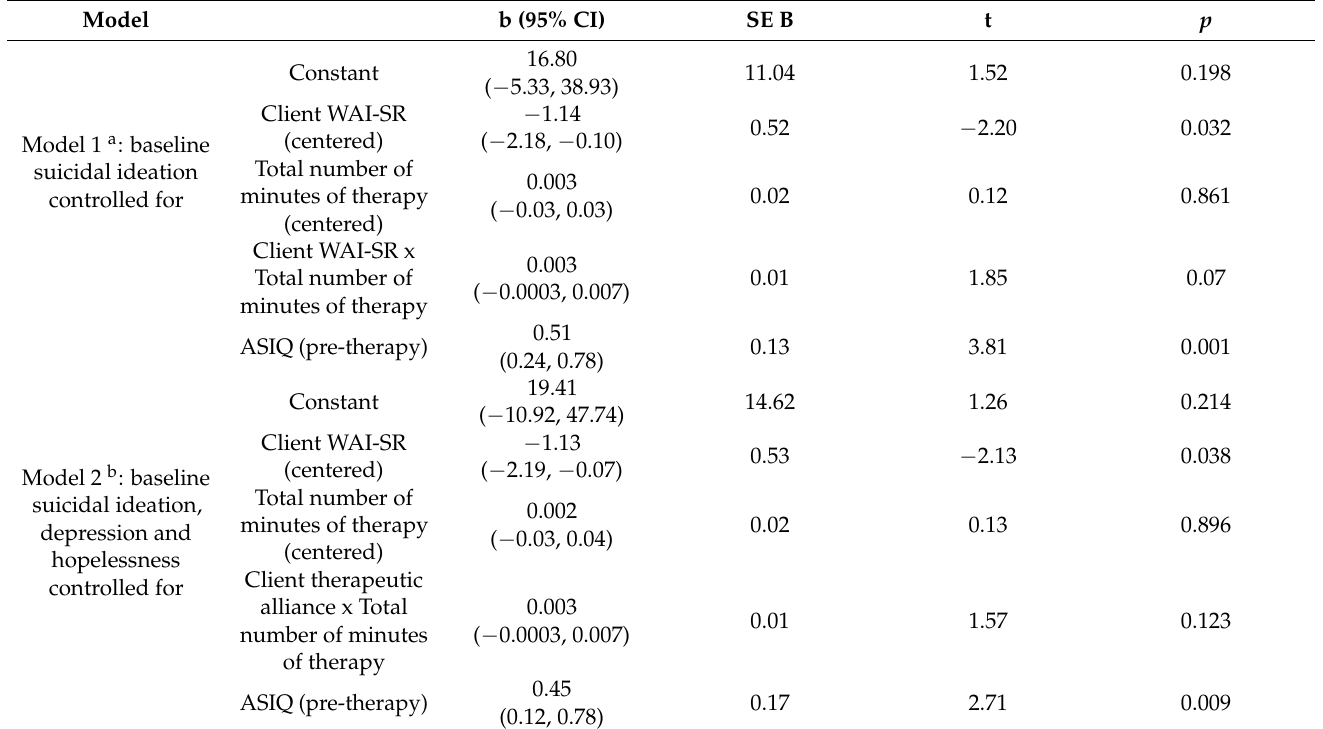
Figure 4. Simple slopes equations of the regression of the therapeutic alliance on suicidal ideation at high, mean, and low levels of total number of minutes of therapy. Note. High, mean, and low values of total number of minutes of therapy are defined as plus and minus 1 SD of the mean (−269.18, 0, 269.18). Low, mean, and high values of the therapeutic alliance score are defined as plus and minus 1 SD of the mean (−8.14, 0, 8.14). Table 4. Results of the moderated linear regression model examining the effect of total length of therapy sessions on the relationship between the client therapeutic alliance and suicidal ideation